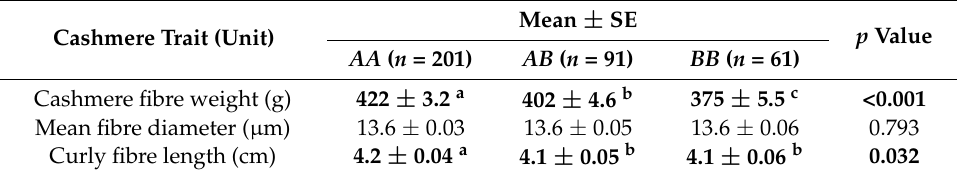
Table 5. The effect of the KRTAP20-2 genotype on various cashmere traits (Mean ± SE) 1 in Longdong cashmere